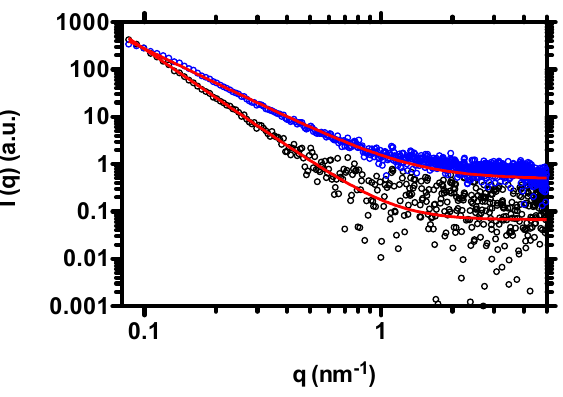
Figure 4. Small-Angle X-ray Scattering (SAXS) pattern profiles of coacervates composed by F A = 0.16 and M v = 220,000 g / mol chitosan. Coacervates are dispersed in deionized water (black dots) and PBS (blue dots). The final medium composition is the following: 90% v / v coacervates in deionized water + 10% v / v deionized water or 10X PBS. The red solid lines represent the best fit of experimental data according to eq. (1).